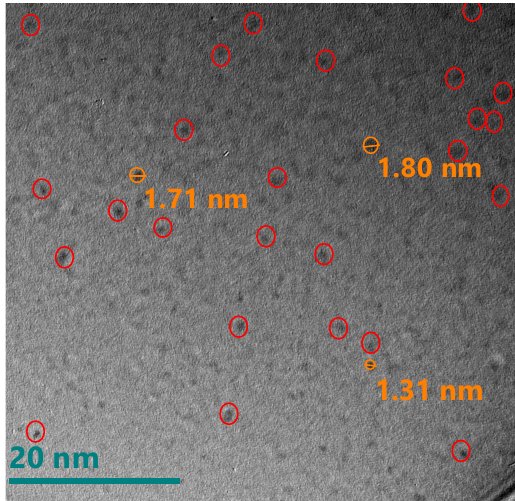
Figure 16. HRTEM micrograph of the D2 SiO x film.